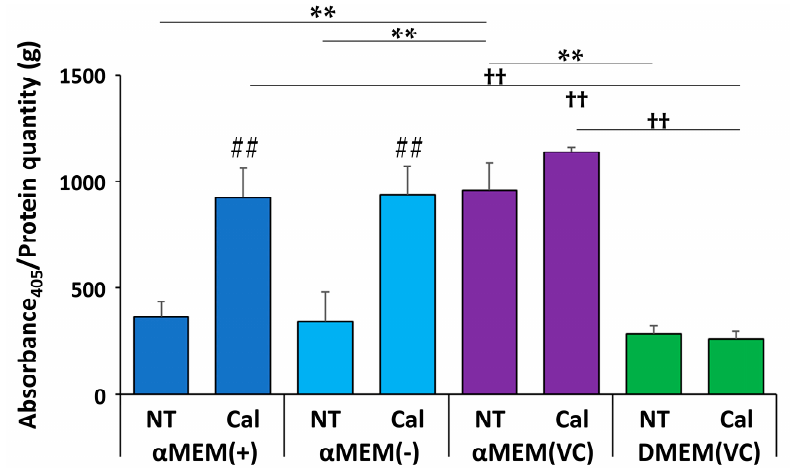
Figure 2. Quantitative results of alkaline phosphatase (ALP) activity in MC3T3-E1 cells 7 d after calcification induction. ALP activity is expressed as Abs 405 /g protein ( n = 3, ** p < 0.01, †† p < 0.01, ## p < 0.01): ** multiple group comparisons among nontreated (NT) media; †† multiple group comparisons among calcification (Cal) media; ## two-group comparison between NT and Cal media.